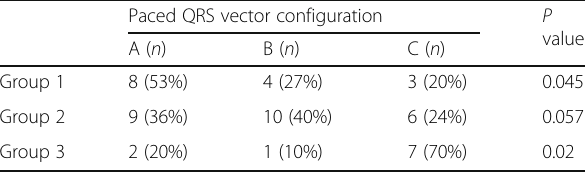
Table 3 Comparison of paced QRS groups regarding vector in leads I and III toward the groups of pacing site